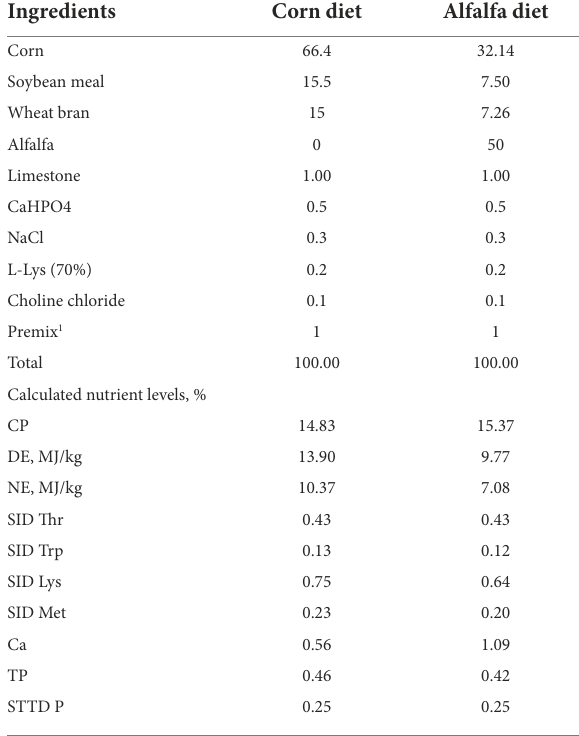
TABLE 1 Composition and nutrient level of experimental diet (as fed-basis).